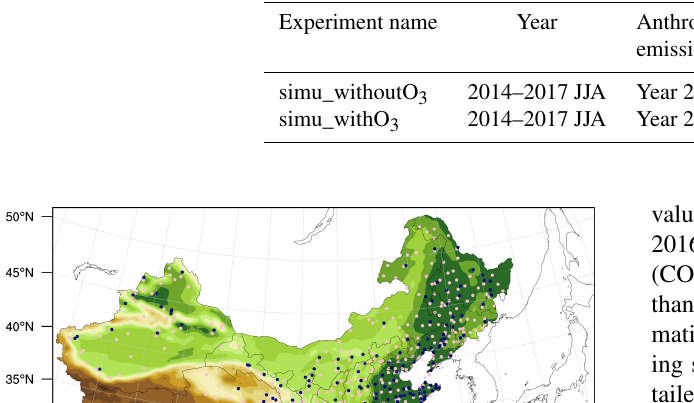
Table 2. Description of the two sets of model experiments. ICs are initial conditions; BCs are boundary conditions.